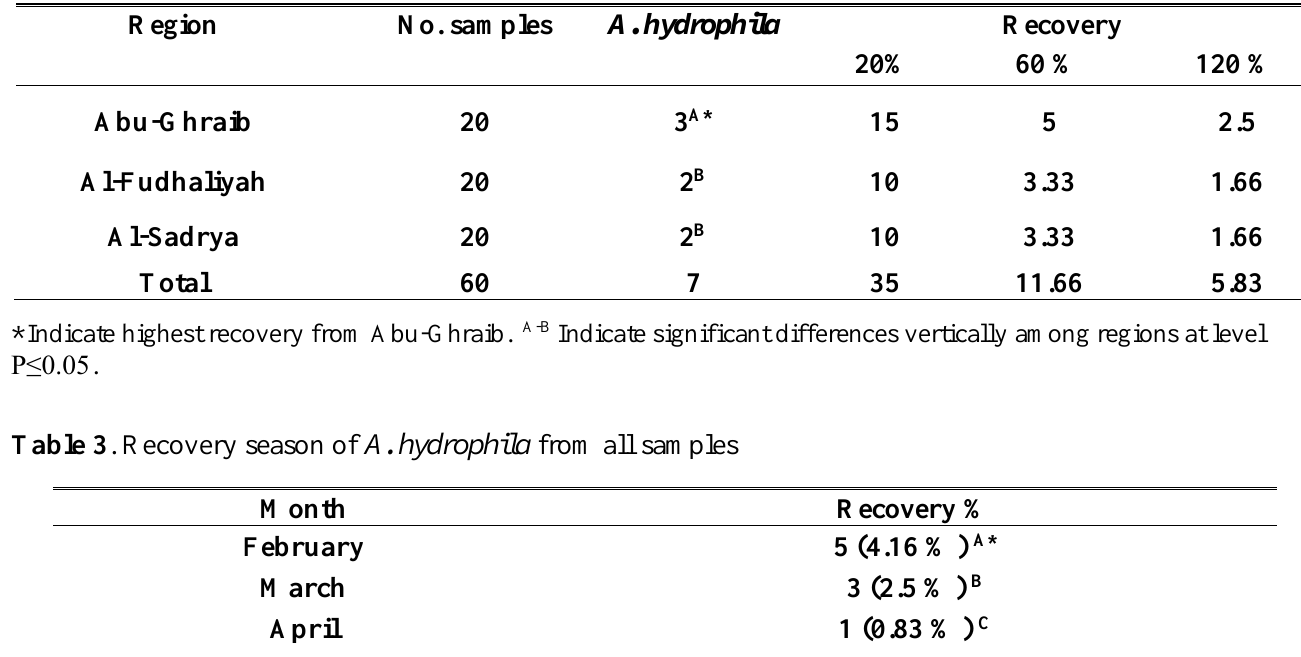
Table 1. Recovery of Aeromonas hydrophila from fresh soft cheese samples